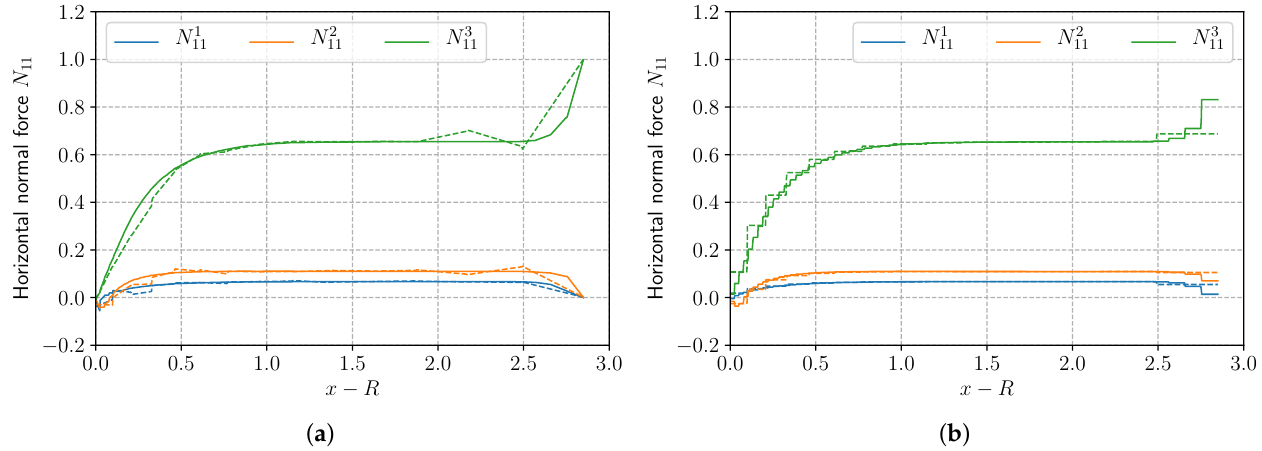
Figure 10. Magnitude